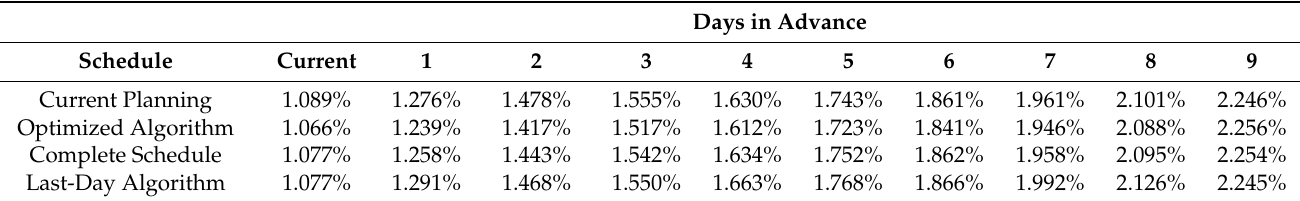
Table 4. MAPE of 2019 when employing each schedule and